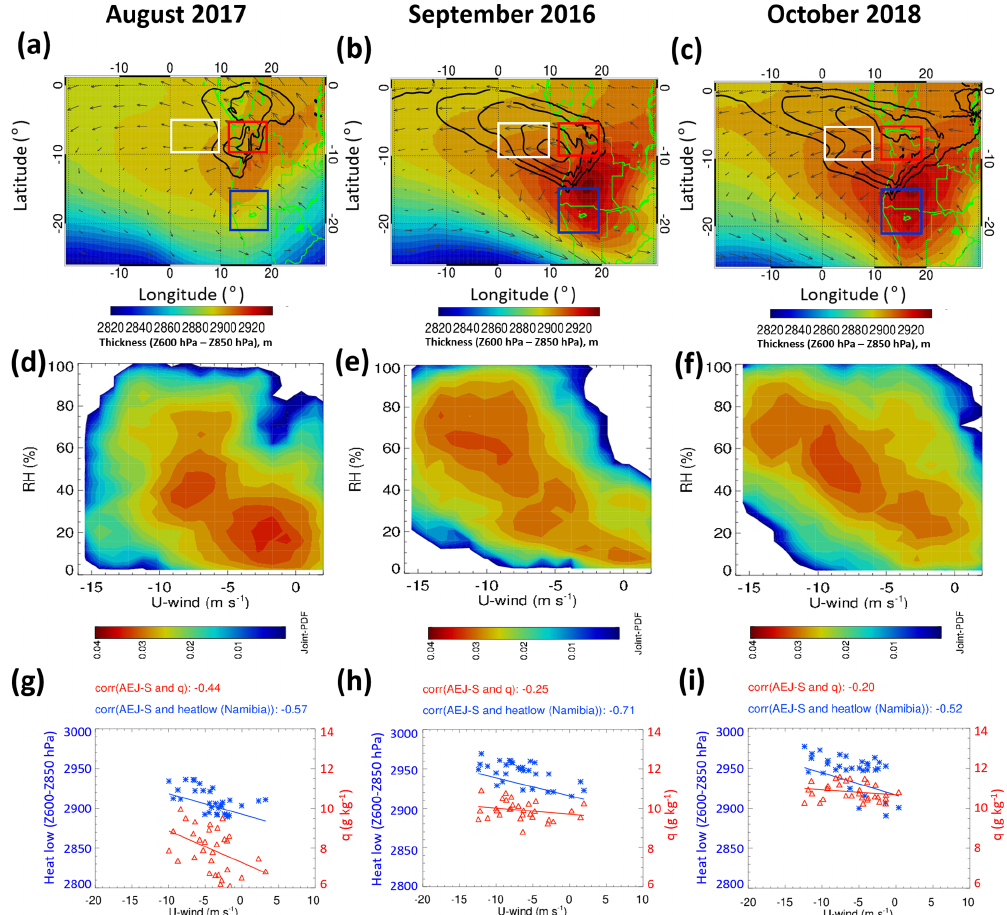
Figure 5. (a) Maps of thickness (geopotential height ( Z ) difference between 600 and 850hPa; meters) overlain by zonal wind (contour; black; ms − 1 ) and wind vector at 700hPa in August 2017. (b, c) The same fields as panel (a) , except for 600hPa in September 2016 and October 2018. (d) The 2-D joint-probability density function (PDF) of zonal wind at 700hPa and RH at 700hPa in August 2017 averaged over the jet exit region (white box region; 0–10 ◦ E, 5–10 ◦ S). (e, f) The same as panel (d) except for 600hPa in September 2016 and October 2018. (g–i) The blue squares represent the scatterplots of 700hPa zonal wind (white box region; 0–10 ◦ E, 5–10 ◦ S; ms − 1 ) and heat low (blue box region; 12–18 ◦ E, 15–21 ◦ S; meters) for August 2017. The red triangles denote the scatterplots of the 700hPa zonal wind (white box region; 0–10 ◦ E, 5–10 ◦ S; ms − 1 ) and 850hPa specific humidity ( q ; red box region; 12–18 ◦ E, 5–10 ◦ S; grams per kilogram; hereafter gkg − 1 ) for August 2017. (h, i) The same as panel (g) except for 600hPa zonal wind in September and October. The hourly data at 18:00UTC on each day of the month are used for panels (a) – (c) and (g) – (i) . Each point in panels (g) – (i) refers to data at 18:00UTC on each day of the month. The 6h data are used for generating panels (d–f) . The boxed regions are shown in panels (a–c)